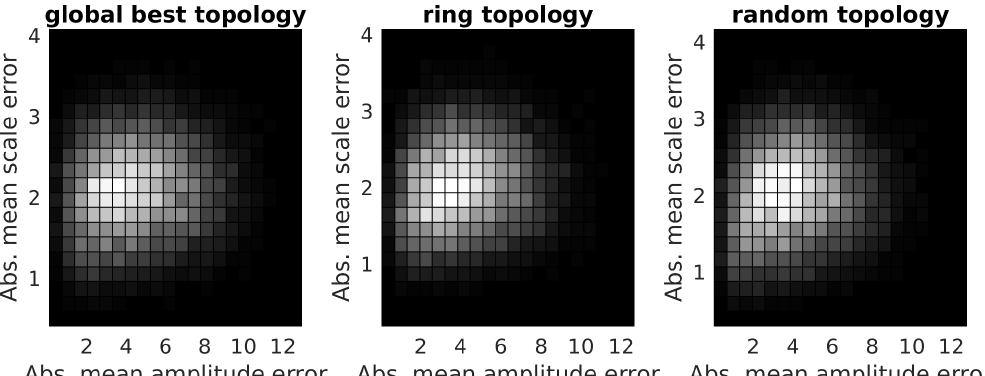
Figure 6. The relation of absolute mean amplitude error and absolute mean scale